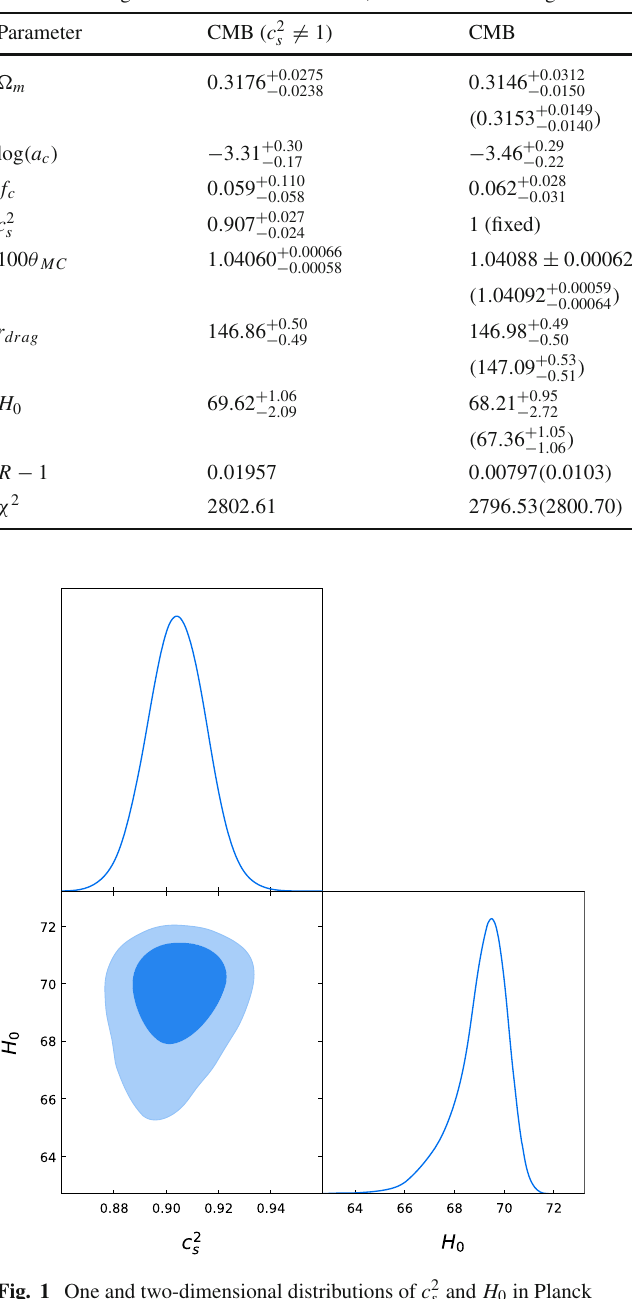
Table 3 Fitting results for the eADE model, where the limits are given at 95% CL. We also added the corresponding (cid:2) CDM result inside brackets